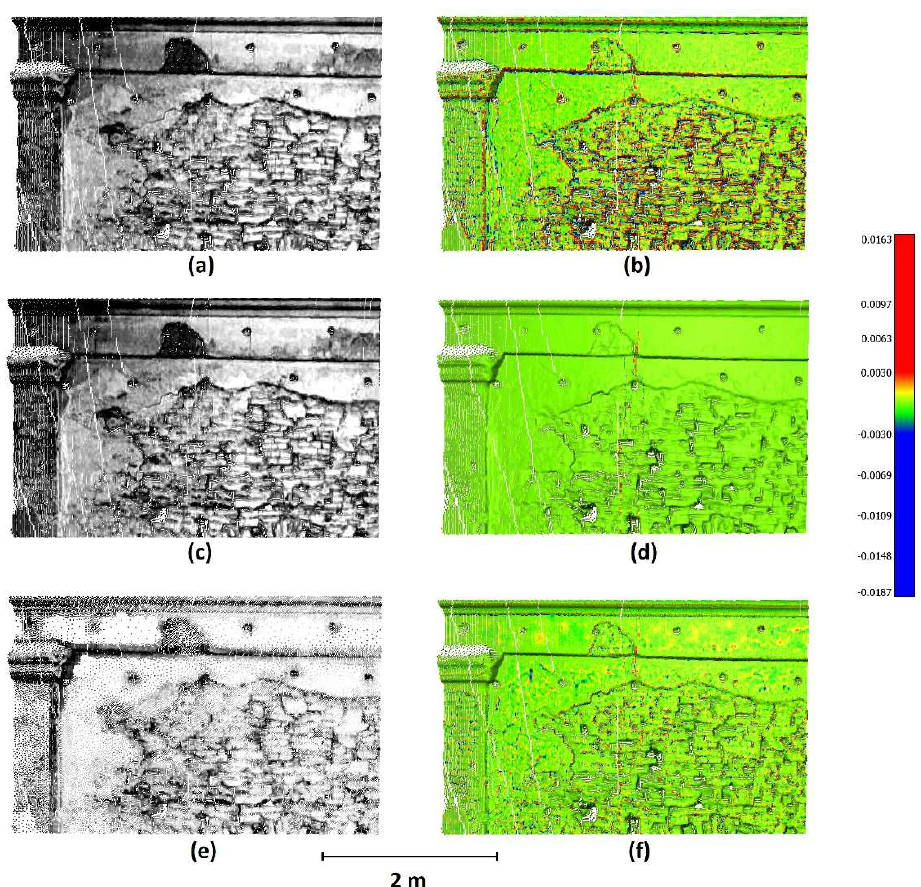
Figure 9. Details of the Data 2 point cloud: ( a ) original cloud, ( b ) differences between the cloud acquired by uniform dilution with a = 0.02 m and the original point cloud, ( c ) point cloud after uniform dilution with a = 0.01 m, ( d ) differences between the cloud acquired by uniform dilution with a = 0.01 m and the original point cloud, ( e ) point cloud after a = 0.01 m b = 0.10 m progressive dilution (approximately the same number of points in the cloud as for uniform dilution 0.02 m), ( f ) differences between the cloud acquired by progressive dilution with a = 0.01 m b = 0.10 m and the original point cloud.